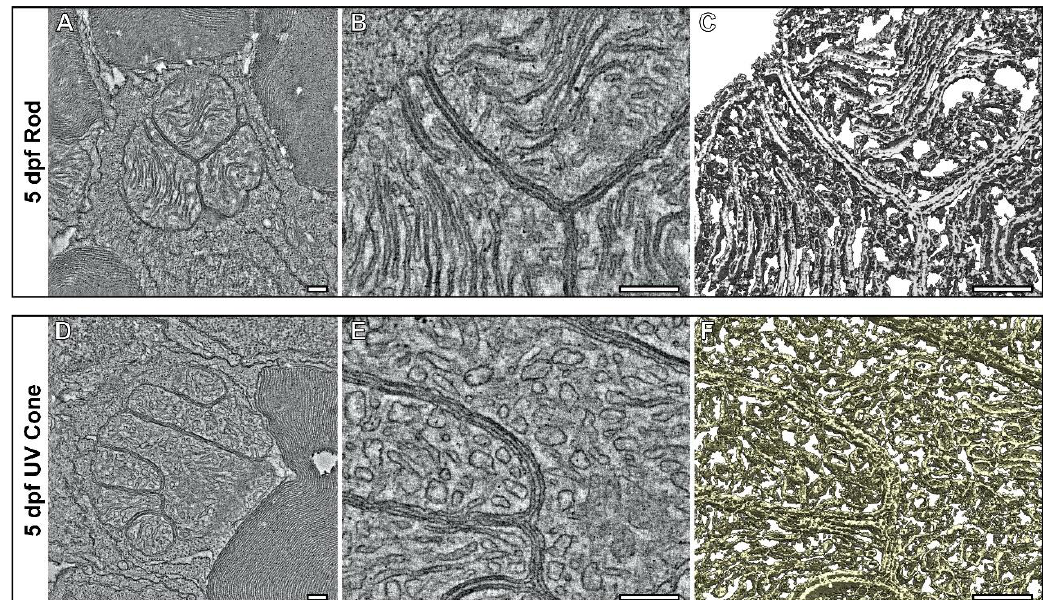
Figure 4. Tomograms show the compact association of mitochondria within the inner segments of UV cone and rod photoreceptors at 5 dpf. ( A – C ) Tomography data of rod and ( D , E ) UV cone inner segment mitochondria. ( A , D ) Single slices from the tomograms with ( B , E ) higher magnification views. ( C – F ) Surface rendering of the tomography data allows the architecture of the mitochondria to be assessed in 3D. The rod has elongated and tightly associated cristae membranes, whereas the UV cone has cristae that are wider. Scale bars = 250 nm.